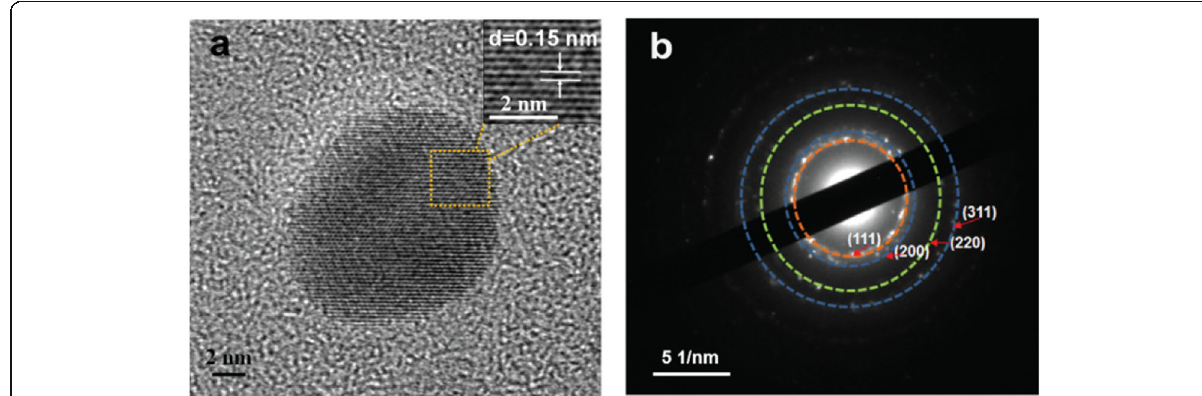
Fig. 2 a Lattice fringes of Ag NPs in the HR-TEM image, b circular rings of Ag NPs from the typical selected-area diffraction (SAED)